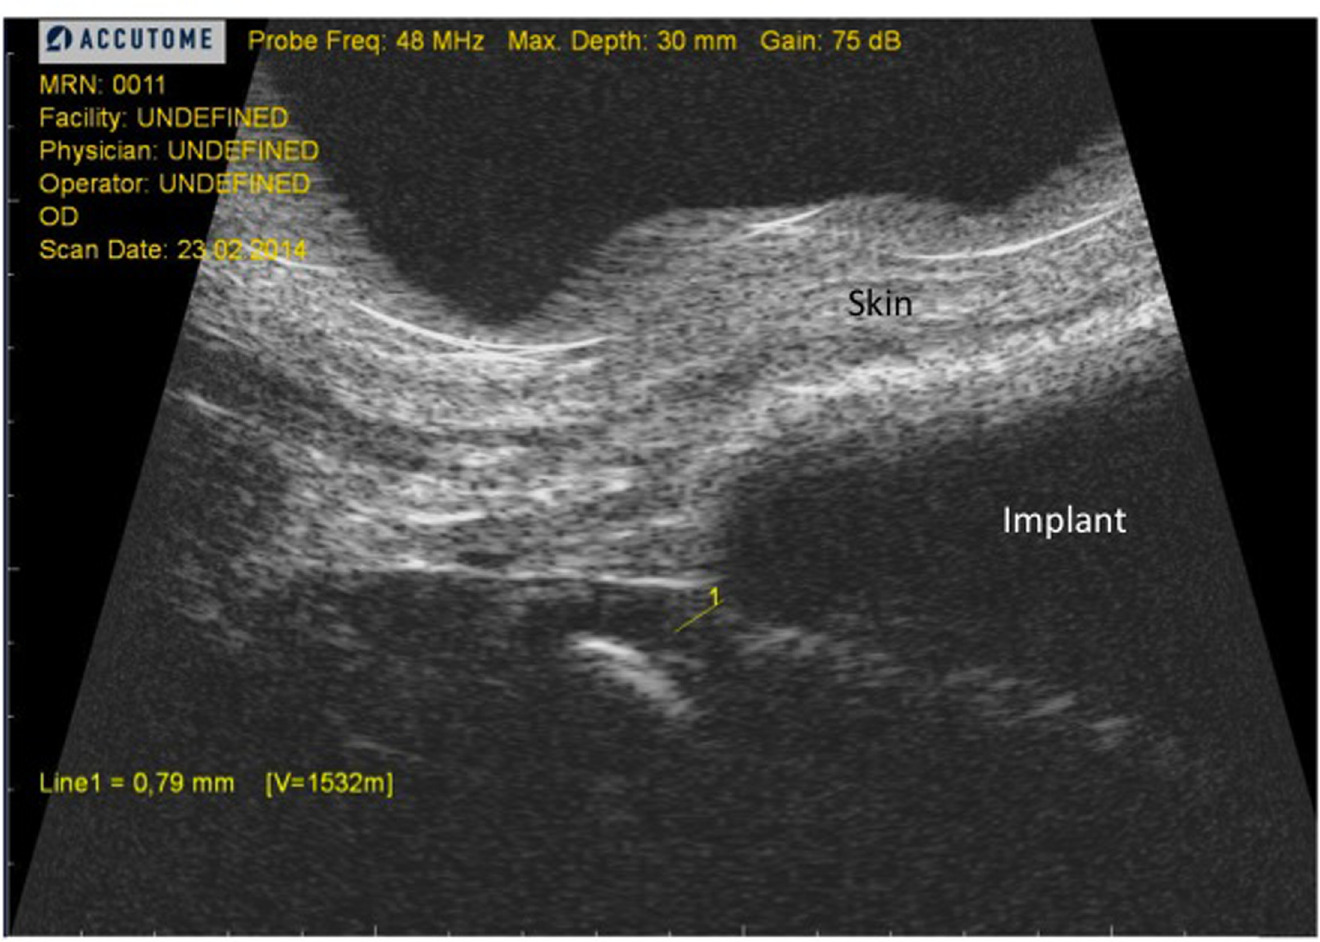
Fig 5. Example picture of HR-US image. Measurements were performed at the outer margin of the implant (yellow line). Scale was adjusted automatically by the software.